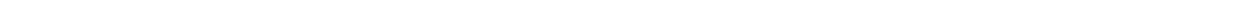
Fig. 4 FBXO32-dependent nuclear localization of CtBP1 is essential for epigenetic and transcriptional remodeling of critical EMT genes. a Differential expression analysis showing signi fi cantly differentially expressed genes upon CtBP1 depletion in HMECs undergoing EMT for 4 days. b A venn diagram showing the overlap of downregulated genes upon CtBP1 and FBXO32 depletion in HMECs undergoing EMT for 4 days and on the right hand, heat map showing their expression along with epithelial HMEC. c RNA-seq data showing the mRNA levels of key EMT-associated deregulated genes upon CtBP1 depletion. The y-axis represents the normalized tag count. d ChIP assay using an anti-Myc antibody to assess the binding of Myc-CtBP1 to its target promoter in HMLE cells induced with TGF- β for 4 days and transfected with either control siRNA or siRNA against FBXO32. q-PCR was performed for the indicated gene promoters, and gene enrichment was plotted on the y-axis as the ratio of precipitated DNA (bound) to total input DNA and normalized with intergenic region. e FAIRE assay was performed to assess the chromatin accessibility of EMT-associated deregulated genes in HMLE cells induced with TGF- β for 4 days and transfected with control siRNA or siRNA against CtBP1. Quantitative PCR was performed for the indicated gene promoters, and gene enrichment was plotted on the y-axis as the ratio of precipitated DNA (bound) to total input DNA and normalized with intergenic region. f , g A similar analysis as in d but ChIP performed for the H3K4me3 mark ( f ) and H3K9me3 mark ( g ). h , i Enriched motifs at the promoters of downregulated genes upon FBXO32 and CtBP1 knockdown ( h ) and ( i ) respectively. j A Venn diagram showing the presence of ATF3 motifs on or in close proximity to the promoters of genes that were downregulated upon FBXO32 and CtBP1 knockdown in HMEC. k A similar analysis as in d but with ChIP performed in HMLE cell for ATF3 and gene enrichment was plotted on the y-axis as % of total input. IgG were run as a control. l ATF3 ChIP were performed in HMLE cells undergoing TGF- β induced EMT and depleted for FBXO32 or CtBP1 and gene enrichment was plotted on the y-axis as % of total input and normalized to intergenic region. For all above experiments the error bars represent the SEM of three independent biological replicates ( n = 3). * p < 0.05, ** p < 0.01, *** p < 0.001, Student ’ s t test. See also Supplementary Fig.